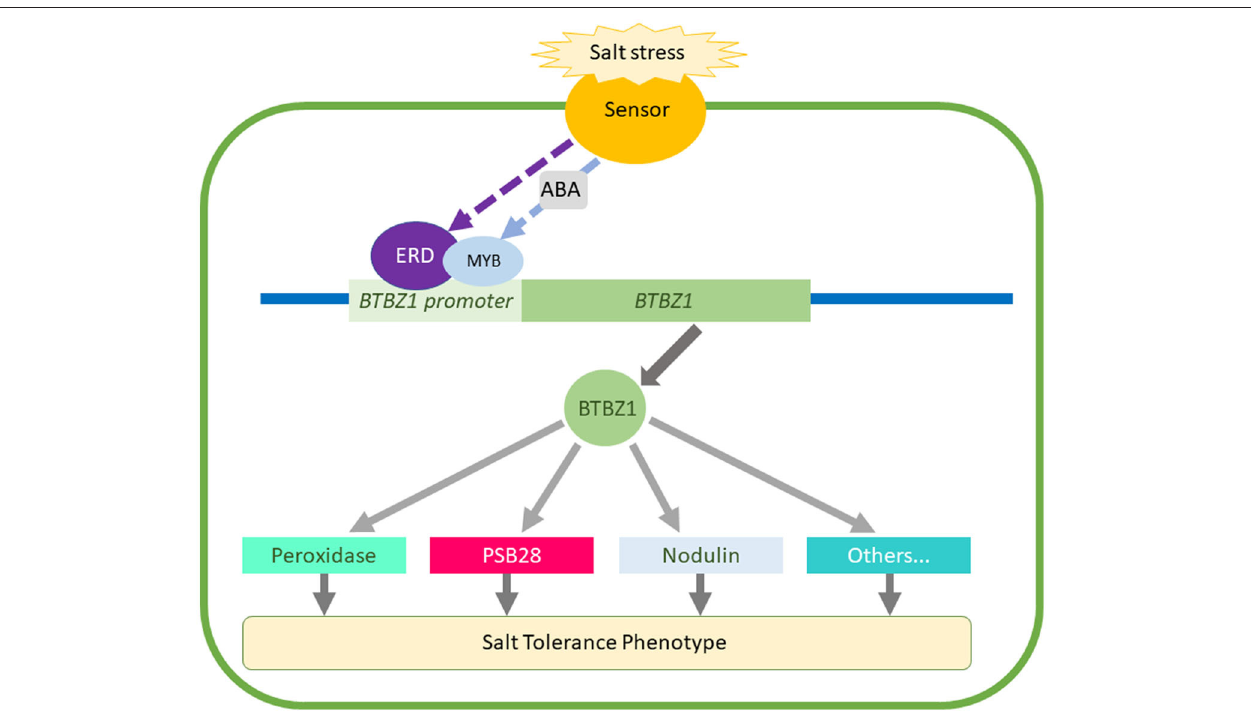
FIGURE 11 | Hypothetical model for the function of the predicted genes obtained from the combining of genome and gene co-expression network analysis.